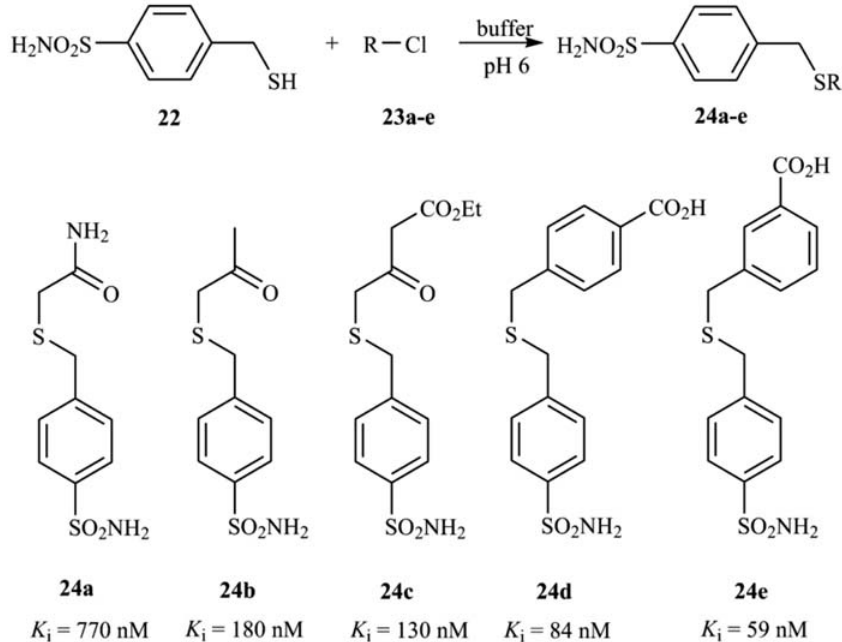
Figure 7. The formation of para -substituted aromatic sulfonamide inhibitors 24a – e of CA-II.